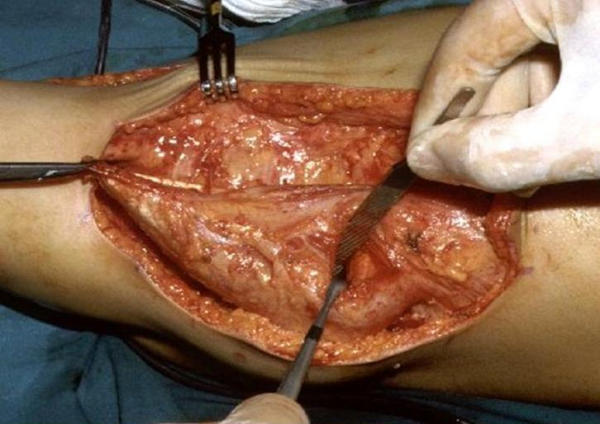
Subscapular muscle release. Subscapularis muscle is released from the anterior surface of the scapula subperiostally.